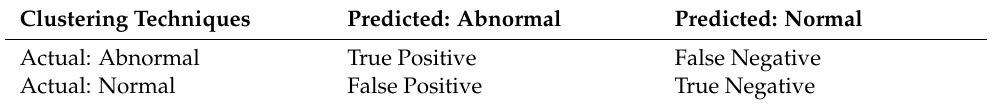
Table 2. Matrix of confusion.